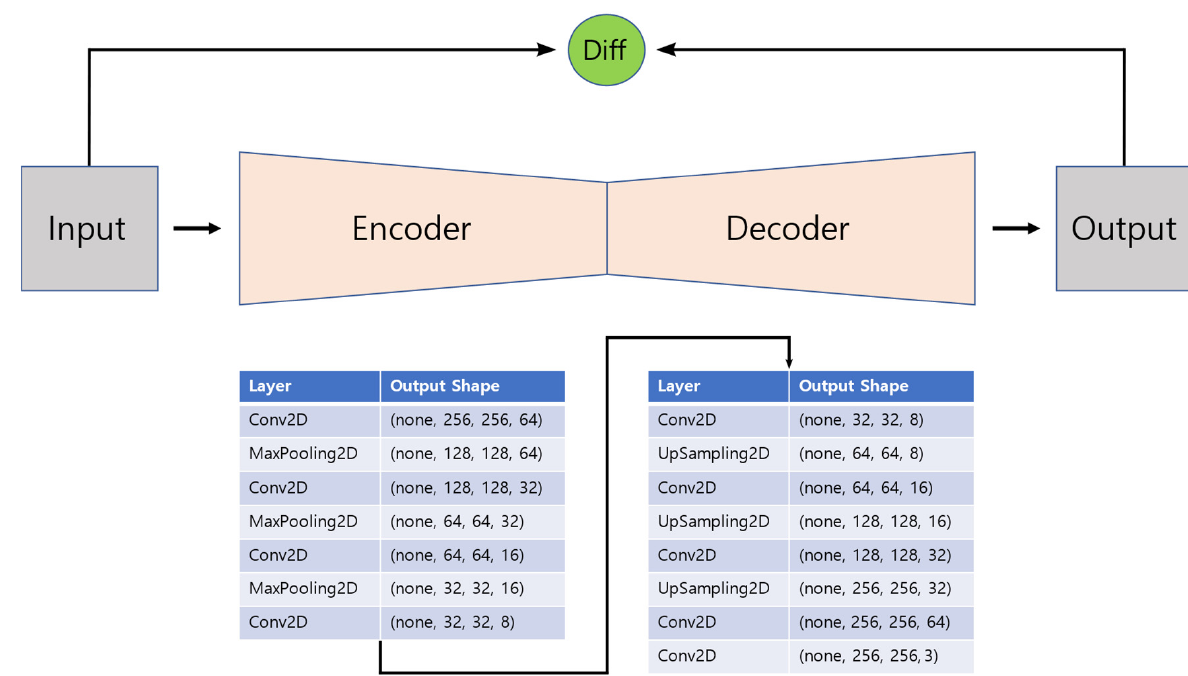
Figure 8. Structure of the CNN autoencoder model for anomaly detection.